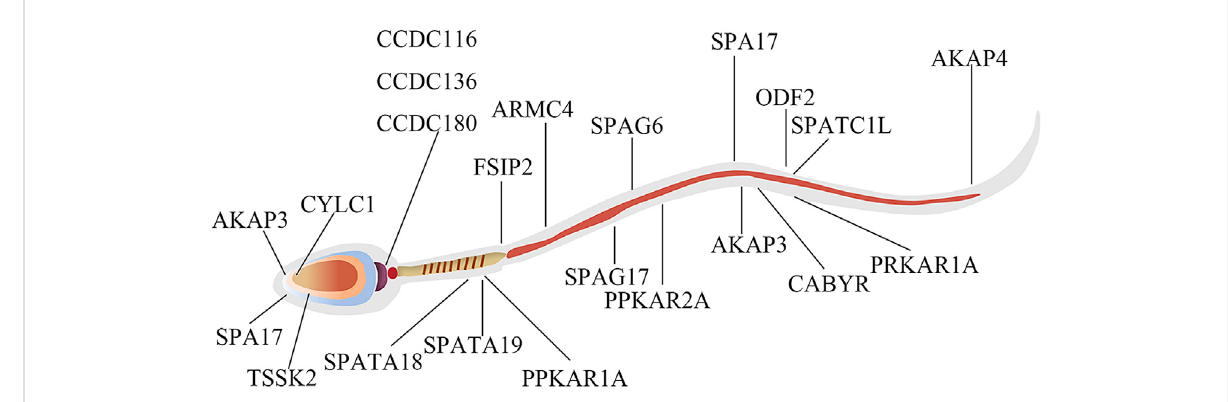
The protein localization map of DEPPs during capacitation and acrosome reaction in yak